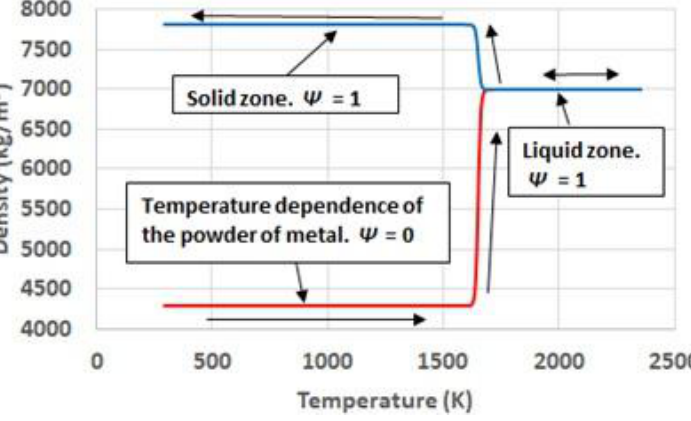
Figure 6. Temperature and phase dependence of density.